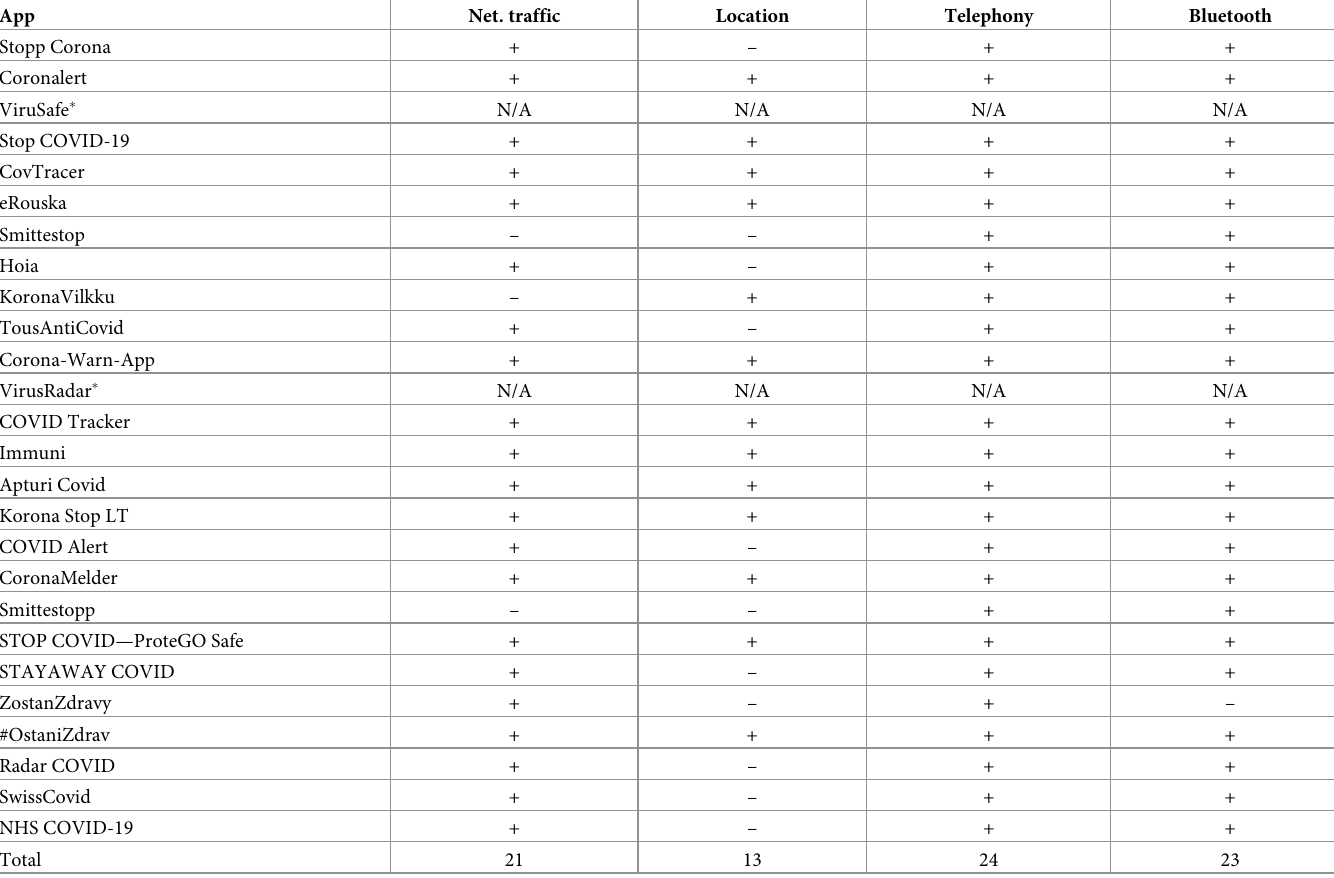
Table 10. Dynamic analysis